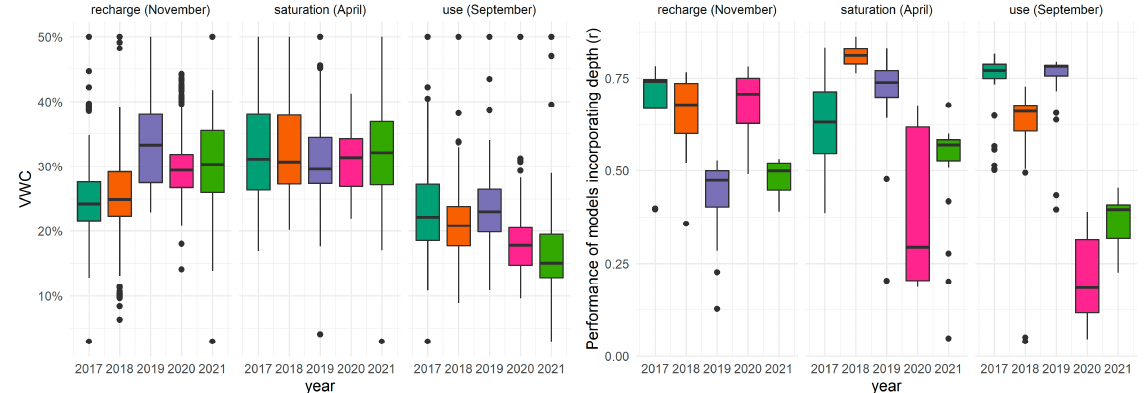
Figure 8. ( left ) Selected months for all available years representing recharge (November), saturation (April), and use (September) periods. ( right ) Pearson correlation strength between VWC measured at all depths and the topographic wetness index calculated with the D8 algorithm [14] on a 7 m resampled DEM for selected months. Each boxplot summarizes the data distribution of daily values for the given month.